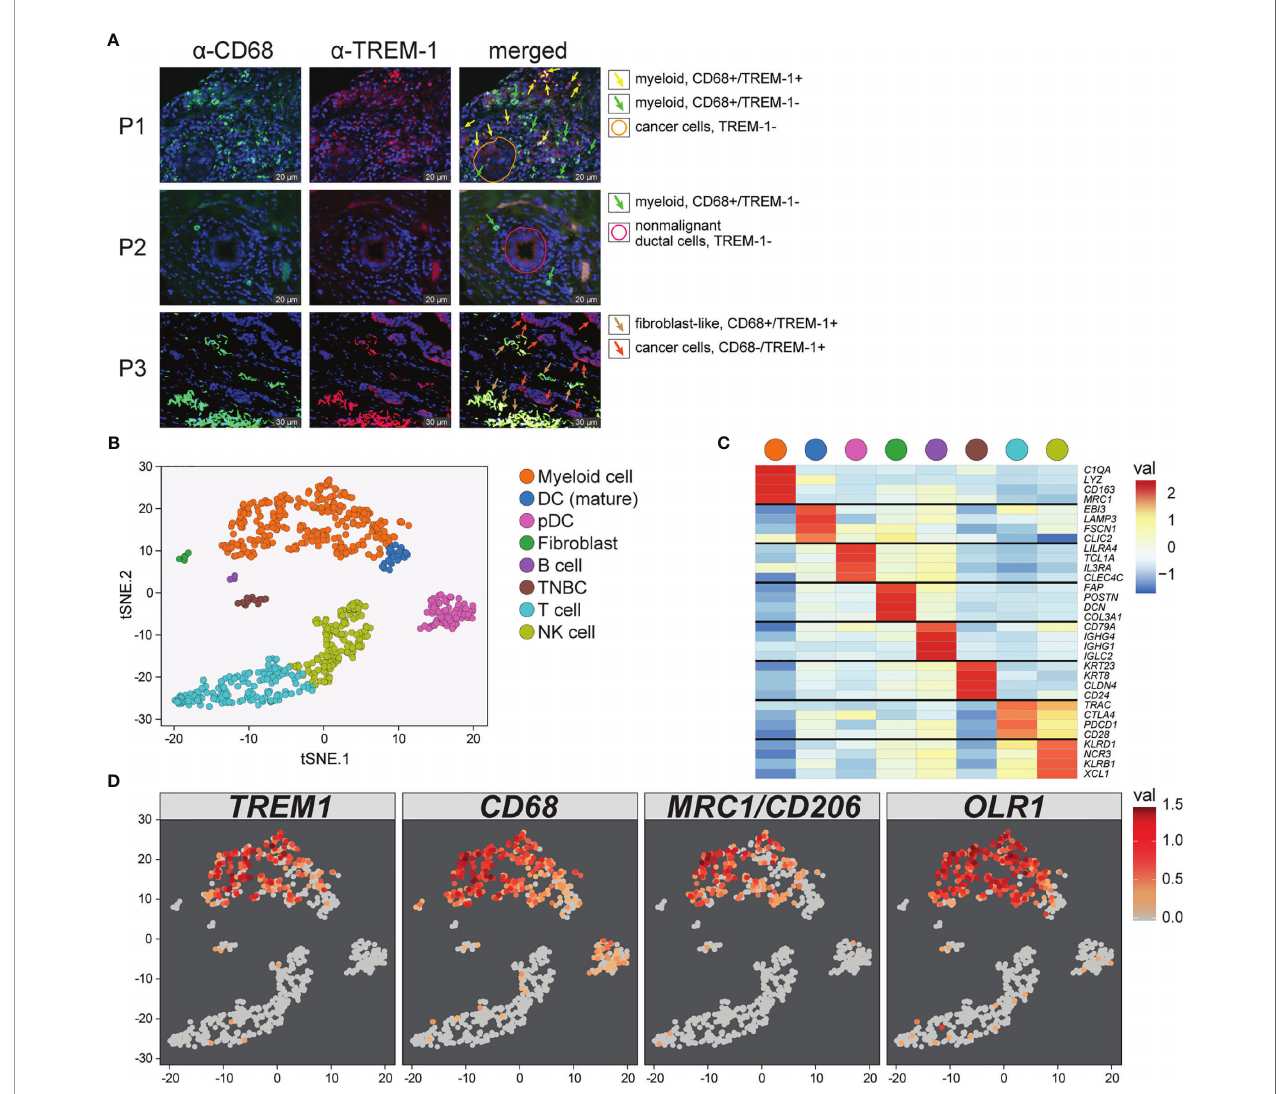
FIGURE 6 | Characterization of TREM1 expression in the breast tumor microenvironment by IF and single-cell RNAseq. (A) Representative patterns (P) of TREM-1 (red) and CD68 (green) immuno fl uorescent staining in breast tumor sections. DRAQ5-stained nuclei are shown in blue pseudocolor. (B) Single-cell RNA sequencing was performed on freshly dissociated cells of a stage III primary triple negative breast tumor. Expression pro fi les of 770 cells were K-means clustered and resolved spatially in a tSNE plot. (C) Cell identities in (B) were assigned based on signi fi cant expression of canonical marker genes. Mean-centered averages of cluster-speci fi c gene expression are shown in the heatmap. (D) Relative expression levels of TREM1 , CD68 , MRC1 (M2 macrophage marker) and OLR1 (MDSC marker) are